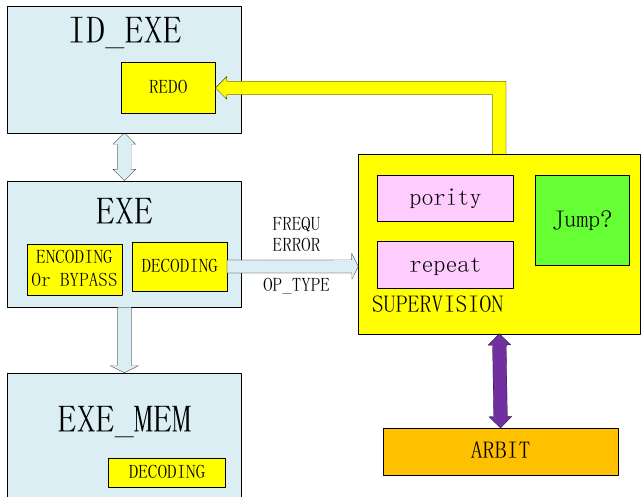
Figure 12. Execution rollback process. The operation in this stage is similar to that in Figure 9, but the instruction type needs to be determined in this stage. Therefore, the Jump module is embedded in this module to determine whether the current execution type is a Control Transfer Instruction and report the information to the ARBIT module.